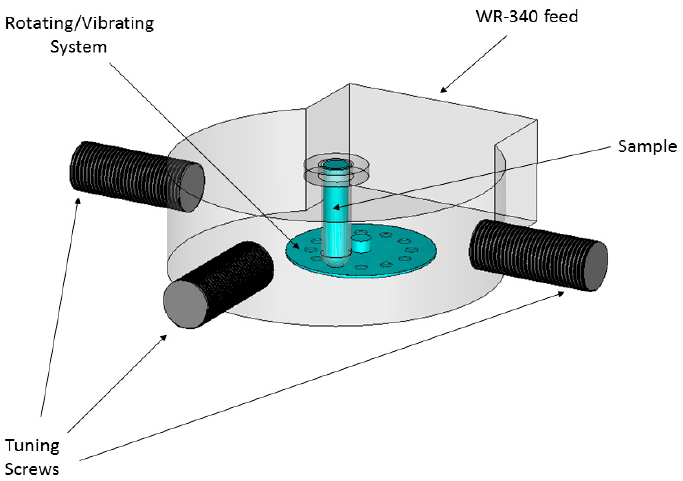
Figure 2. Designed cavity, including the tuning and vibration systems.